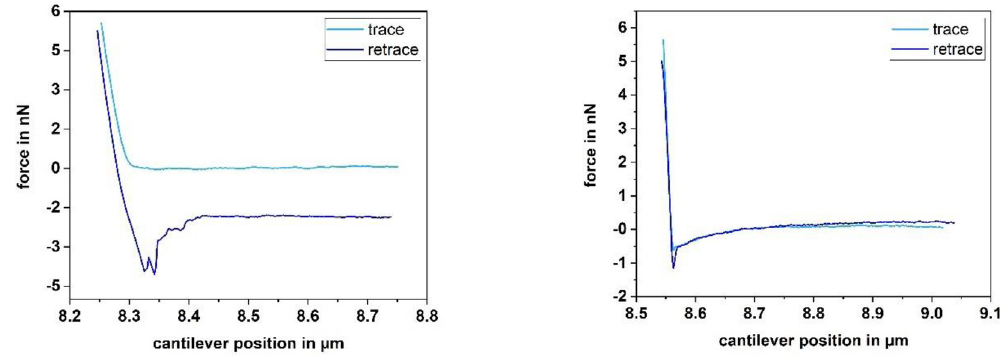
Fig 5. Force-distance curves of a single Lactococcus lactis cell on glass, recorded with the following parameters: Left: Setpoint 5 nN, z-length 0.5 μ m, z-speed 5 μ m/s, pause time 300 sRight: Setpoint 5 nN, z-length 0.5 μ m, z-speed 5 μ m/s, pause time 0.5